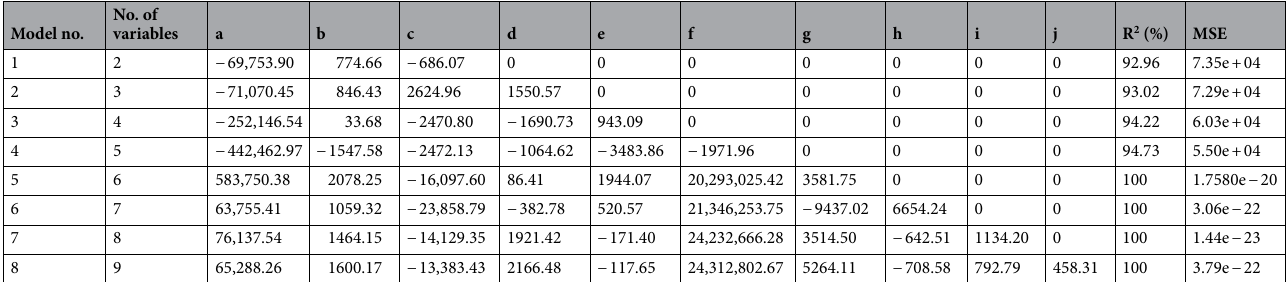
Table 2. The specifications of multivariable model to predict dust concentration.